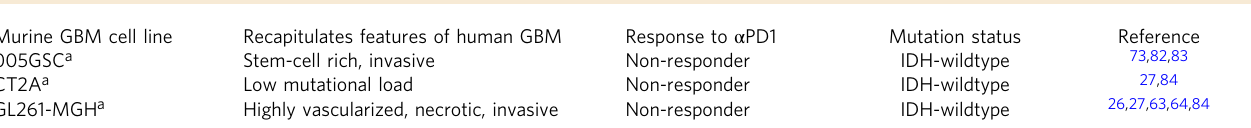
Table 1 Clinical features of the orthotopic, immunocompetent GBM models. Murine GBM cell